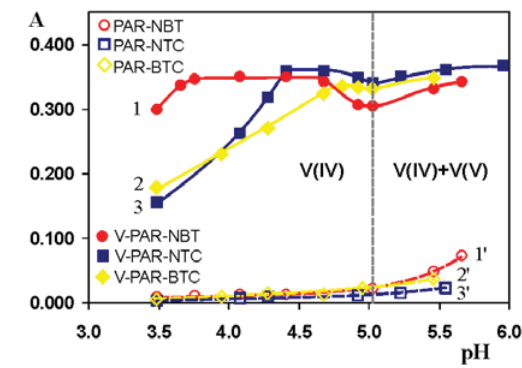
Figure 2. Absorbance of V(IV)-PAR-DTC complexes (1-NBT, =2.0×10 -5 mol L -1 , V(IV) 2-BTC, 3-NTC) and PAR-DTC (1’-NBT, 2’-BTC, 3’- NTC) in chloroform vs. pH of the aqueous phase plots. C =2×10 −5 mol L -1 ; C =C =2×10 −4 mol L -1 , V(IV) PAR DTC l=0.5